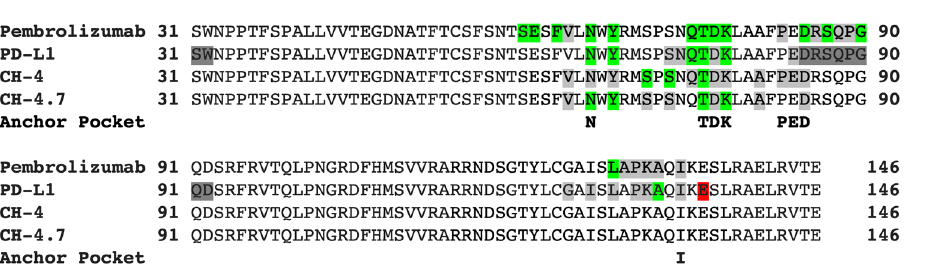
Figure 6. Interaction profiles of PD-1. Interaction profiles were generated by PDBsum 42 using PD-1 structures complexed with pembrolizumab Fv (PDB ID: 5B8C) and PD-L1 (PDB ID: 4ZQK). LIGPLOT 41 examined the interaction between PD-1 and CH-4 and also CH-4.7. The interactive resides in PD-1 are highlighted as red for the salt-bridge interaction, green for the H-bonding interaction, and light gray for the non-bonding interaction. The residues highlighted as dark gray are unmodeled residues of the PD-1 domain containing the 4ZQK